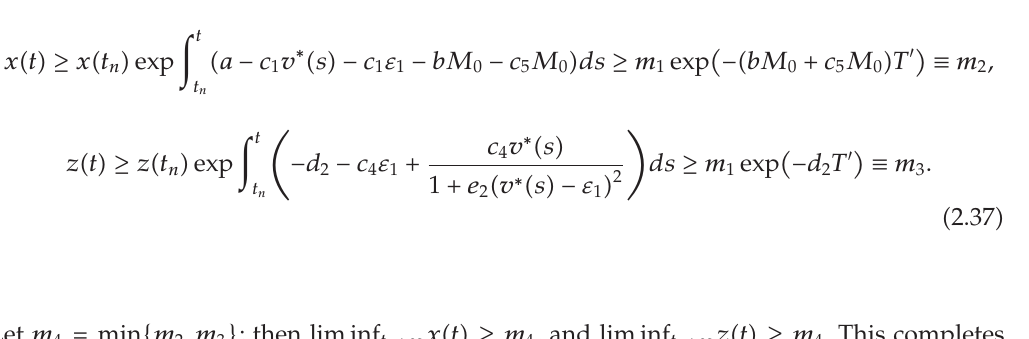
a subsequence { t n contradiction with the boundedness of x (cid:5) t (cid:6) and z (cid:5) t (cid:6) . Therefore, T (cid:7) < ∞ .